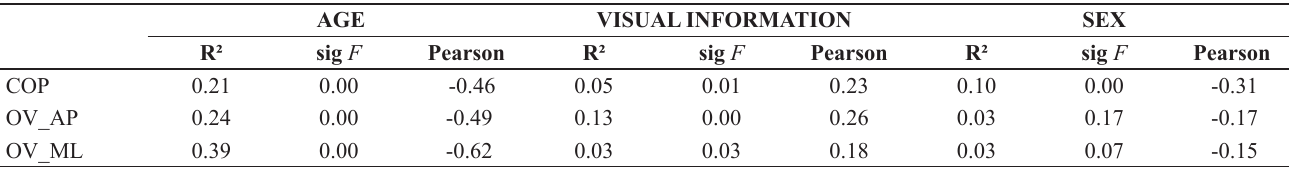
Table 2.Factors influencing postural control among children AGE VISUAL